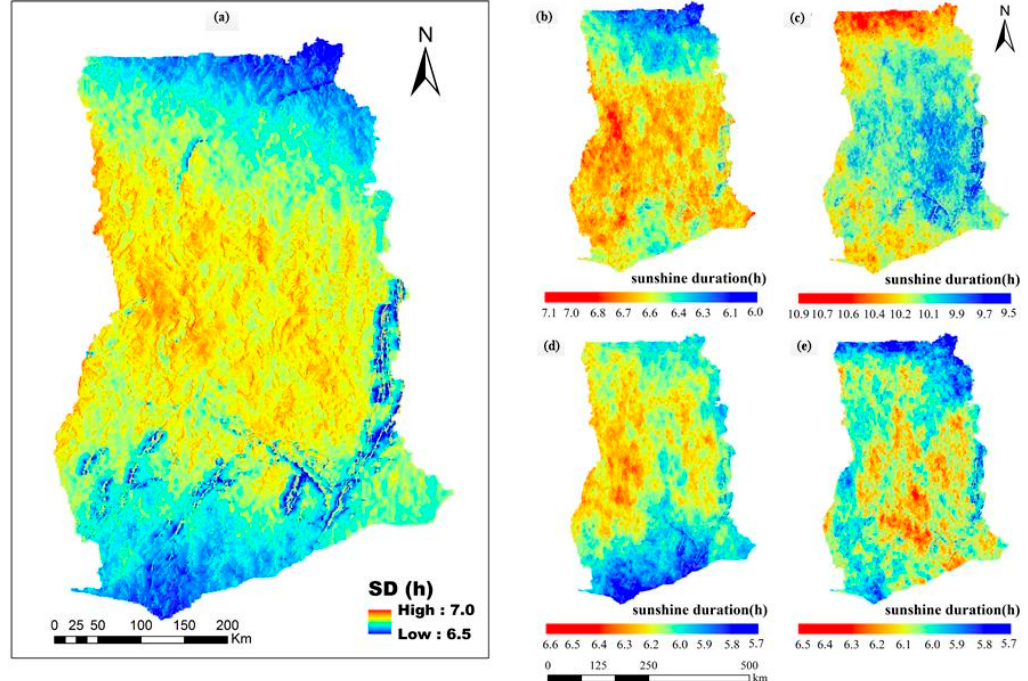
Figure 2. 2010 SD for ( a ) annual, ( b ) January, ( c ) April, ( d ) July and ( e ) October, 2010. High values indicate long SD, and low values indicate low SD (in hours), respectively. SD lies between July (minimum) and April (maximum). Table 2. Summary of error analysis for simulated sunshine duration (SD) over the complex terrain of Ghana.